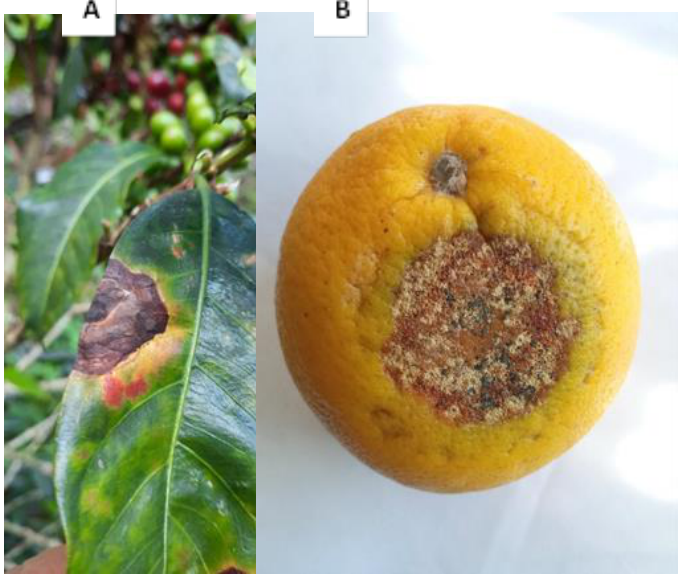
Figure 1. Alternaria leaf spot disease on a coffee plant ( Coffea Arabica , A ) and Alternaria brown spot disease on citrus ( Citrus sinensis , B ). This image shows the leaves’ ( A ) and fruits’ fungal lesions ( B ). Alternaria species are endophytic, saprophytic, and pathogenic, related to diseases in preharvest and postharvest production [39]. The sporulation of these fungi facilitates propagation by the breeze and through vectors such as insects, which contract the spores of phytopathogenic fungi and spread them to healthy plants [40]. Advanced Alternaria infections in crops of economic importance generate putrefaction in postharvest production through cell wall degradation, metabolism of fatty acids, sugars, and the increase in secondary metabolites in their hosts, which are discarded in an advanced disease stage